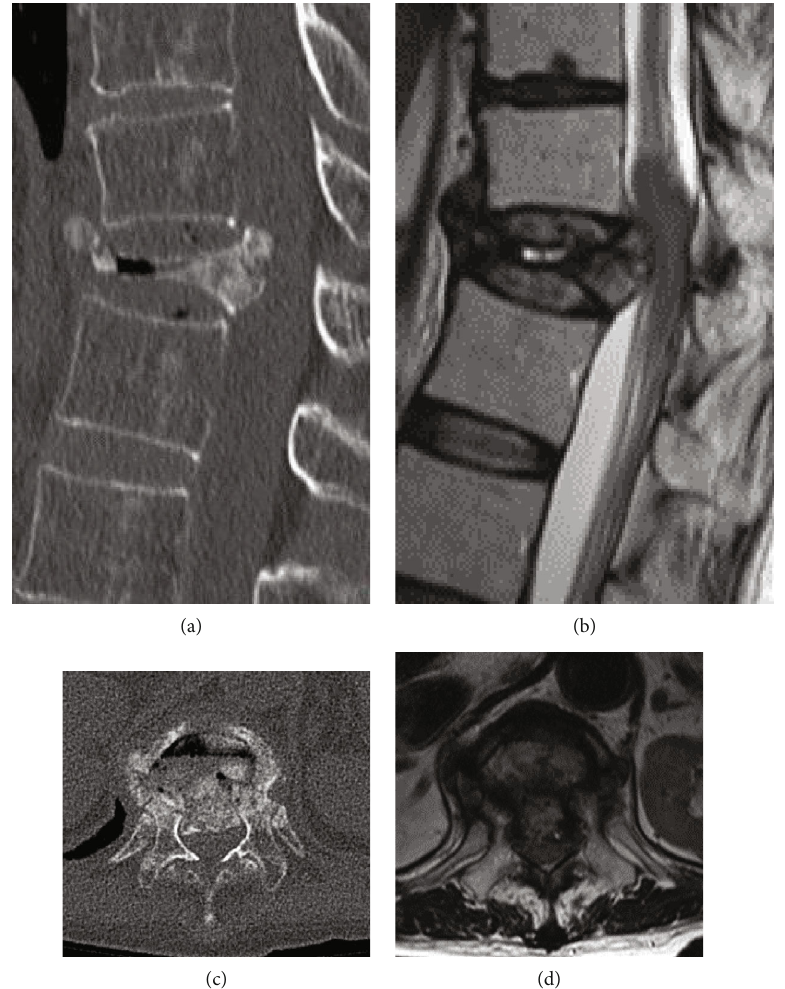
Figure 5: Preoperative thoracolumbar computed tomography (CT) images and magnetic resonance images (MRIs) of a 66-year-old woman with collapse of the 12 th thoracic (T12) vertebra. (a) sagittal CT image; (b) sagittal T2-weighted MRI; (c) axial CT image at the T12 vertebra; (d) Axial MRI image at the T12